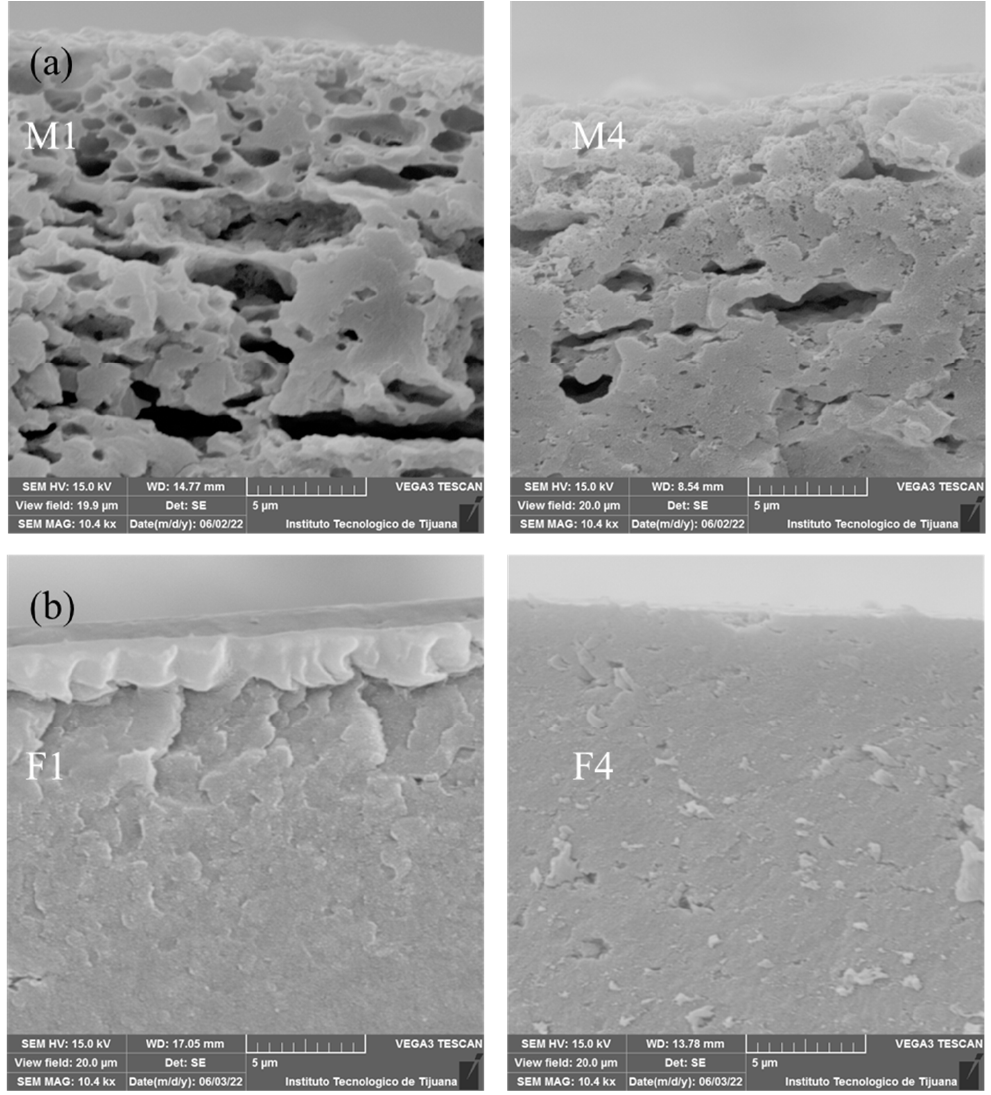
Figure 5. SEM images for membranes: ( a ) M1 and M4 and ( b ) F1 and F4.